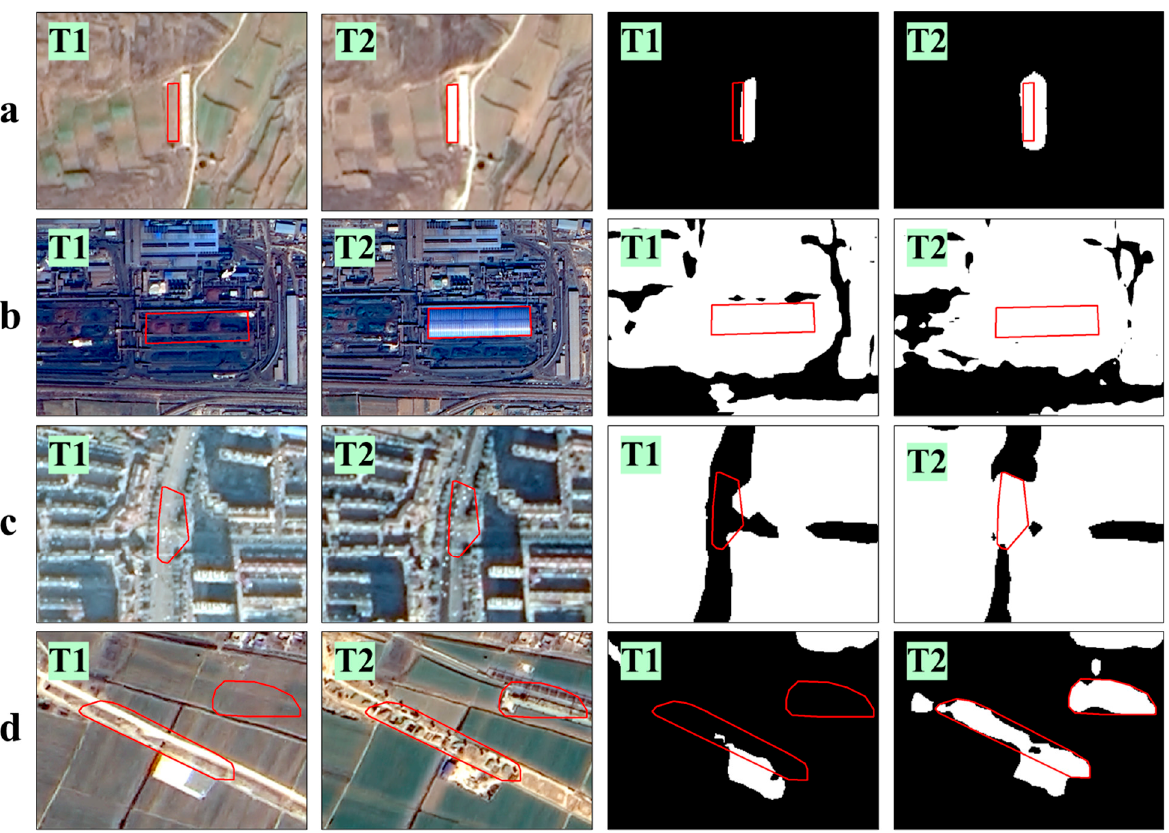
Figure 12. Examples of error types by this method. ( a – d ) represent different examples enumerated. T1 and T2 represent pre-temporal and post-temporal images. The binary images on the right are the masks for T1 and T2 .